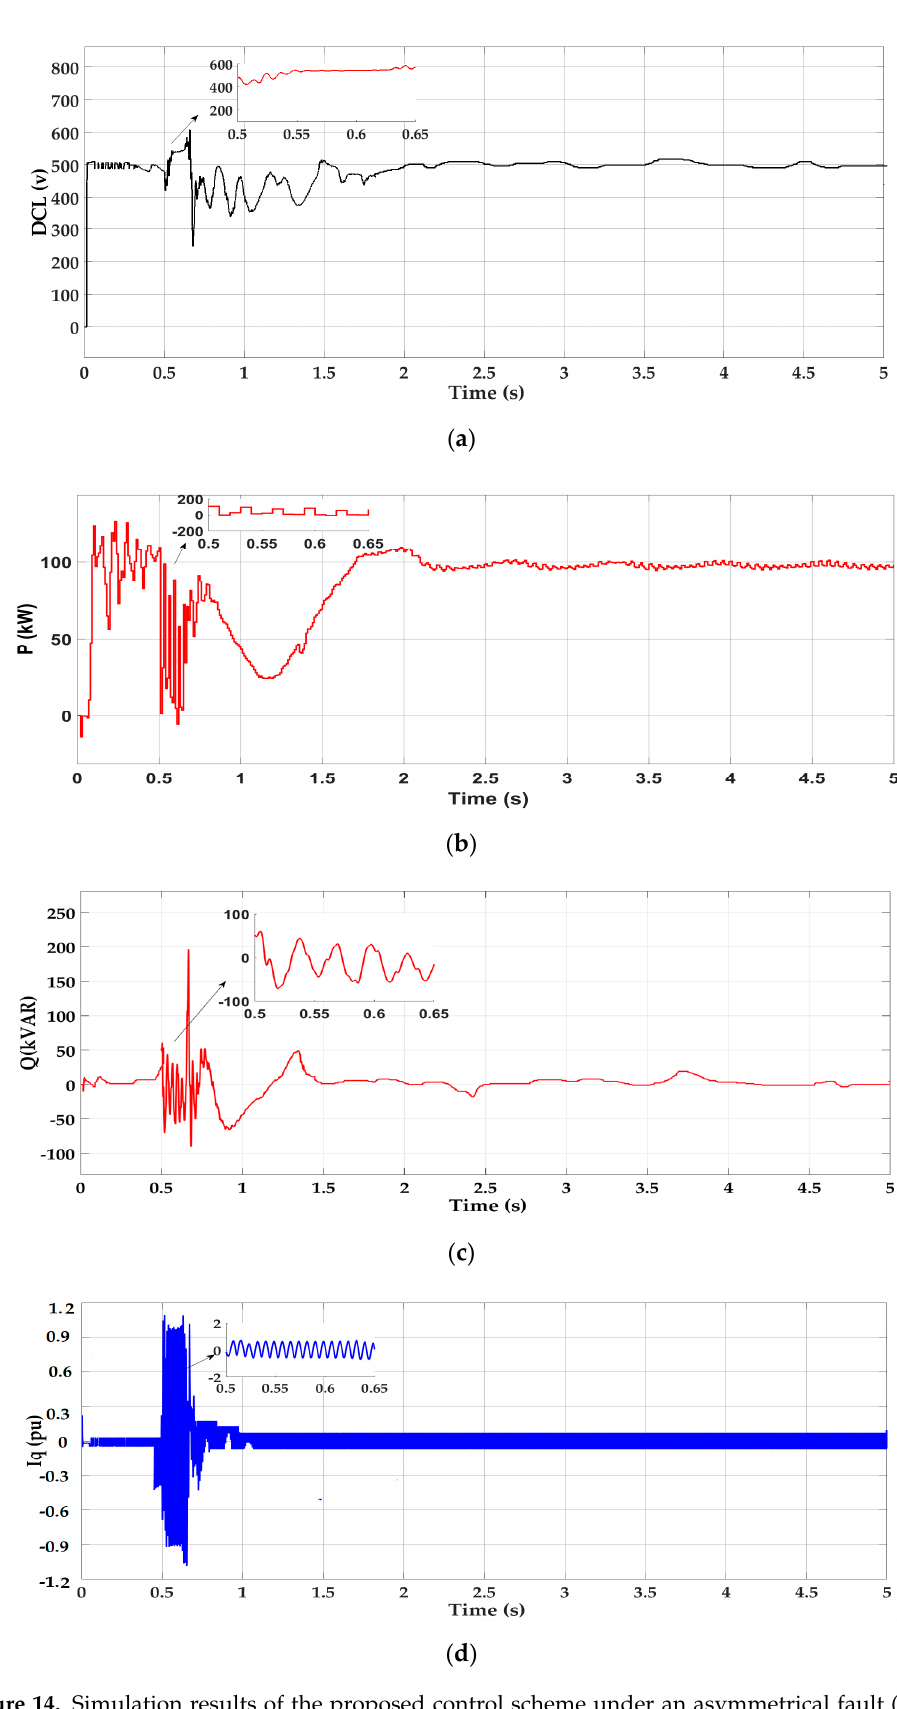
Figure 14. Simulation results of the proposed control scheme under an asymmetrical fault (2-LG). ( a )